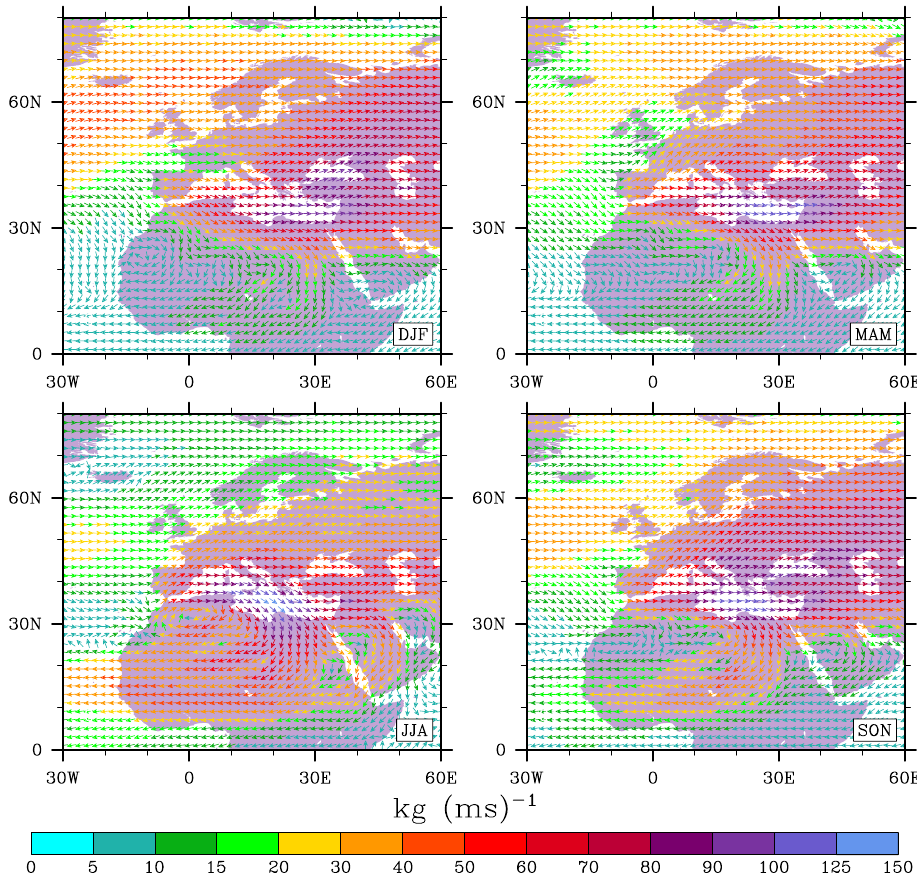
Fig. 11. Calculated moisture flux for particles crossing the Mediterranean basin. For visibility, only every second grid point in x and y direction is plotted. Moisture fluxes are shown for the vertical layer below